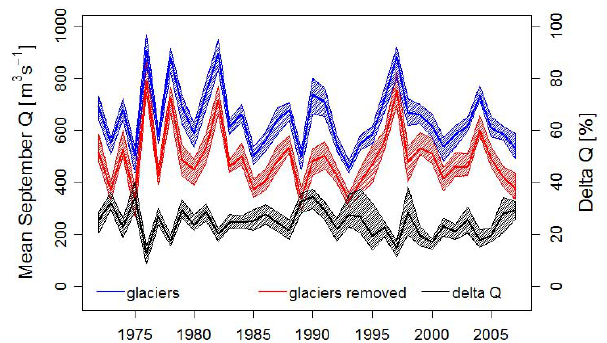
Fig. 8. The effect of glaciers on mean September discharge shown by comparing simulations with and without glaciers including un- certainty limits (5–95% quantile range).